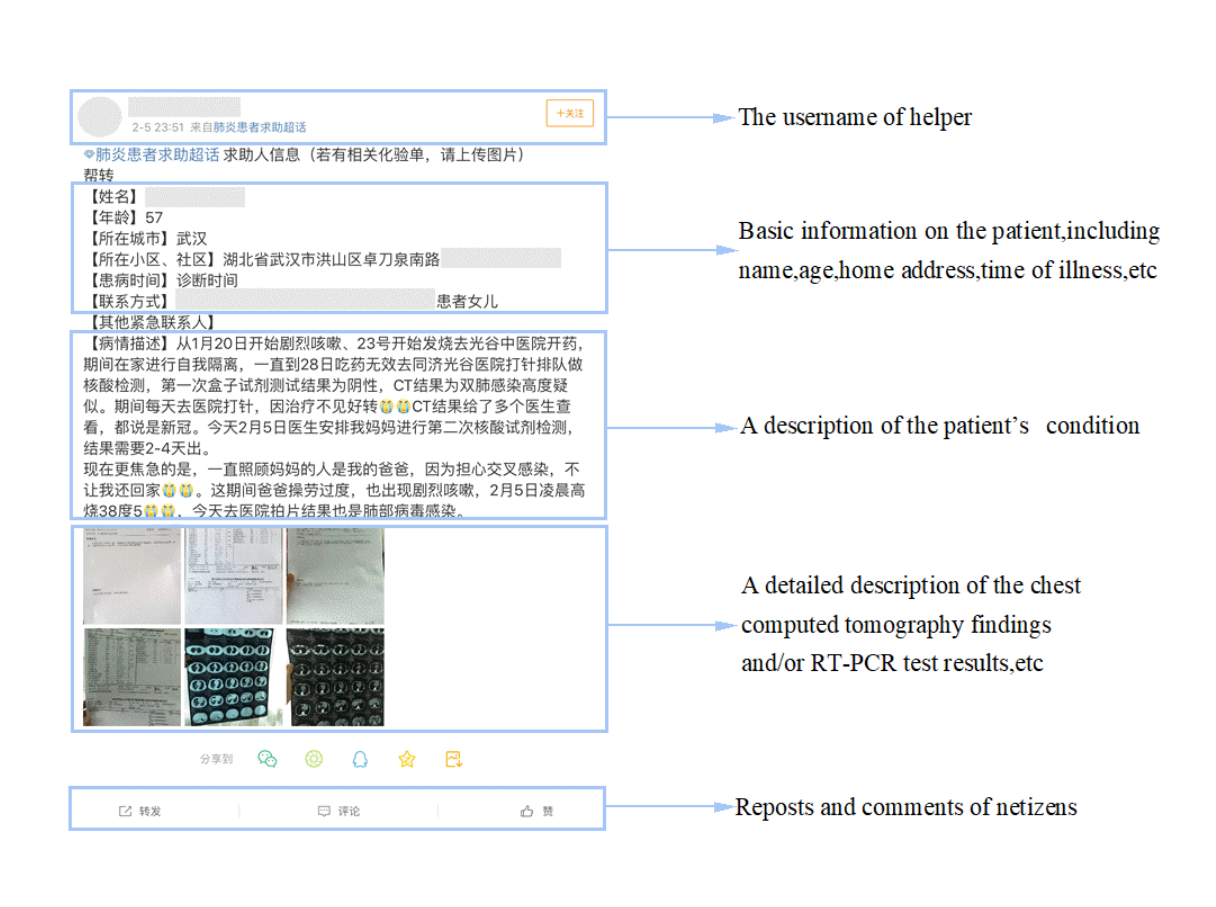
Figure 1. An example of a patient with coronavirus disease (COVID-19) seeking help on Sina Weibo. RT-PCR: reverse transcription-polymerase chain